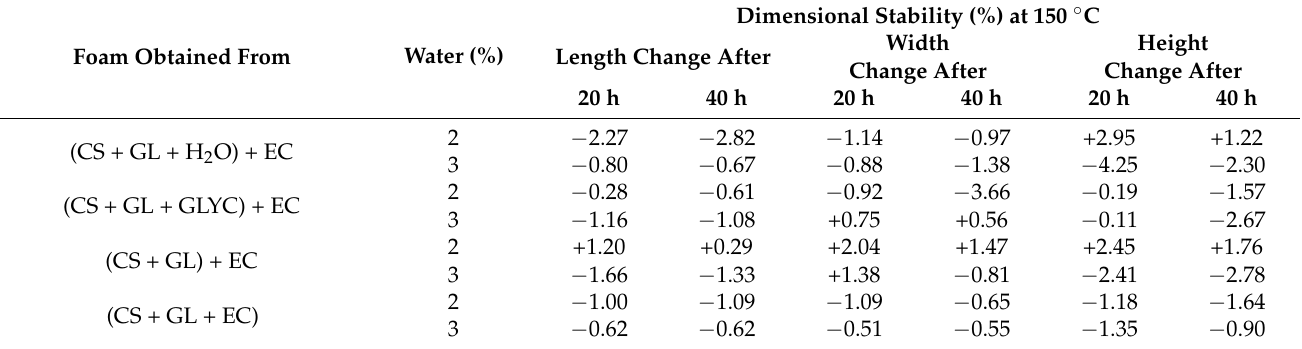
one and shortening in another dimension of exposed PUFs has been observed. Table 7. Dimensional stability at the temperature of 150 ◦ C (determined with ± 1.5% accuracy). Dimensional Stability (%) at 150 ◦ C Width Height Foam Obtained From Water (%) Length Change After Change After Change